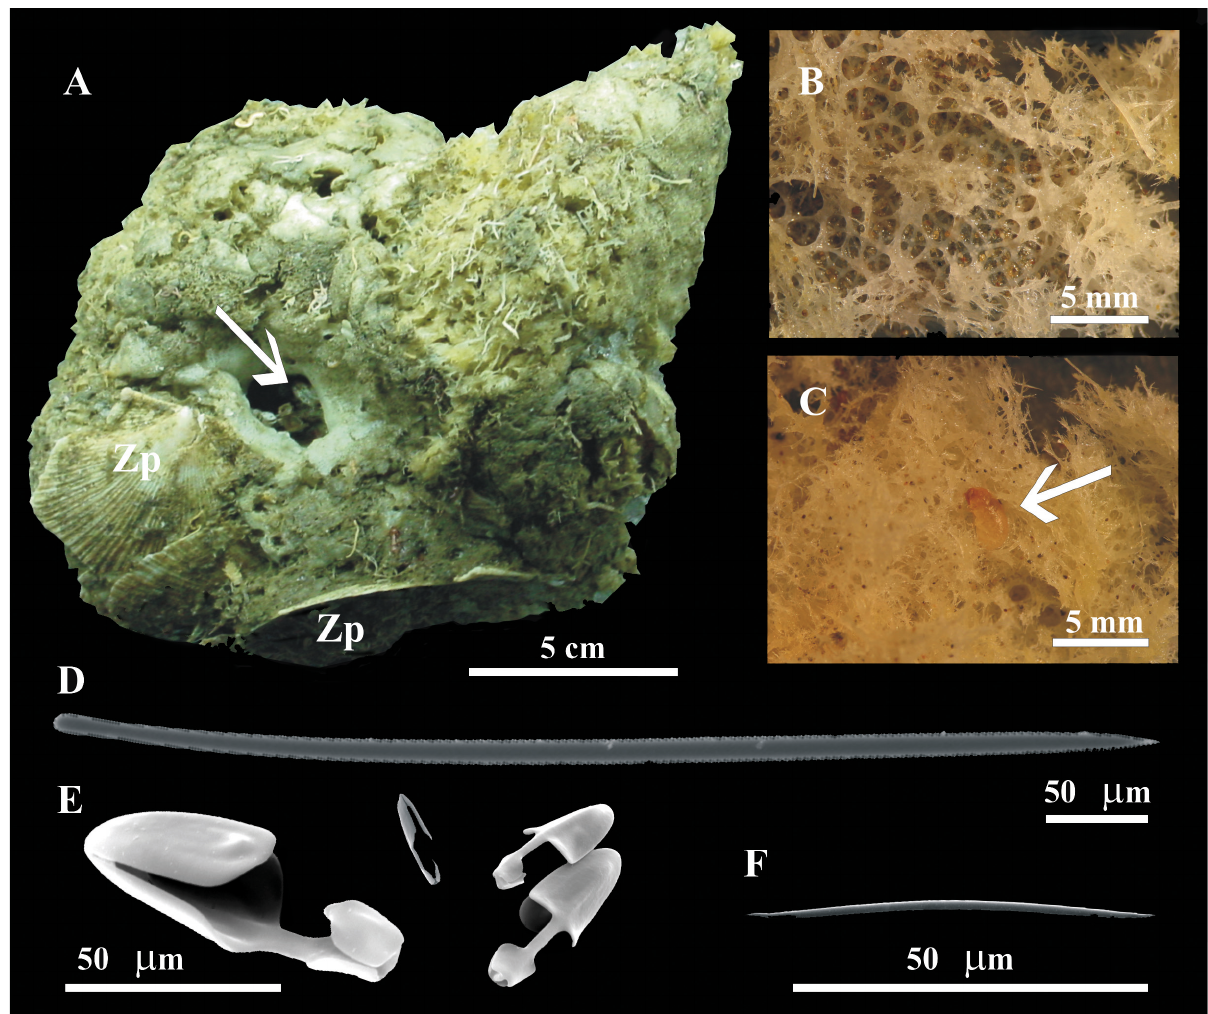
Fig . 2. – Mycale ( A. ) magellanica (Ridley, 1881). A, macroscopic view of one specimen; Zp, Zygochlamys patagonica old shells; arrow shows individuals of Hiatella meridionalis bysally attached in a depression of the sponge. B, C, internal structures of M. ( A. ) magellanica ; arrow shows a specimen of Aristias cf. antarcticus . Spiculation (SEM images): D, mycalostiles; E, anisochelae; F,